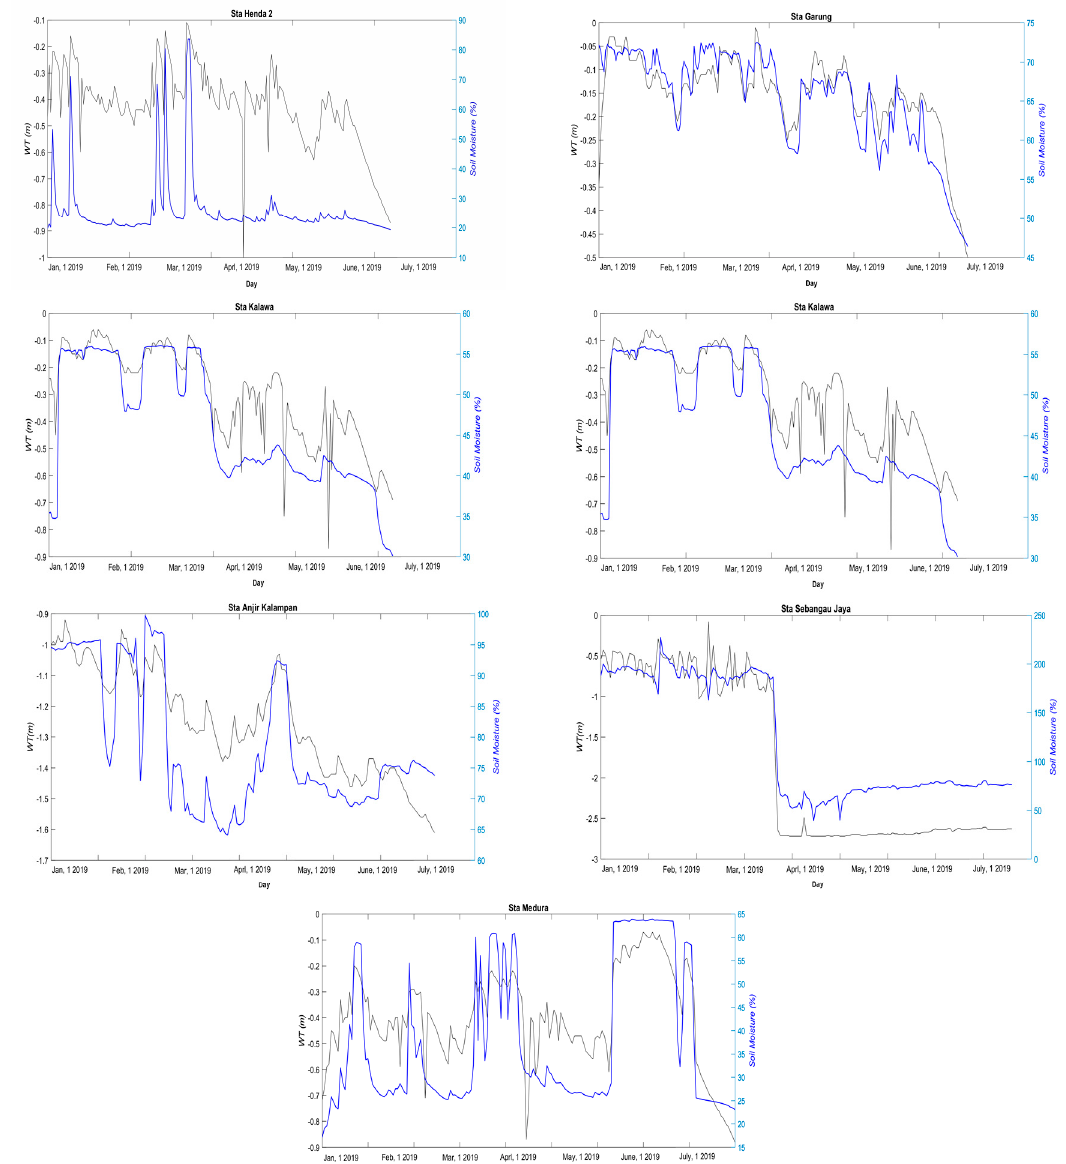
Figure 7. Graph of real-time water table depth of 13 stations in the research area.